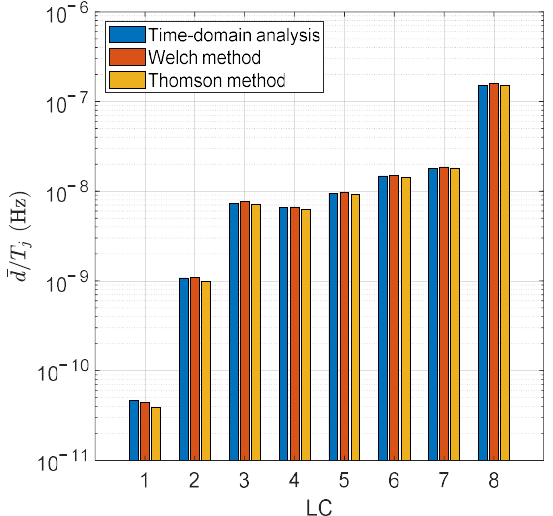
Figure 9. Assessment of cumulative fatigue damage per unit time.